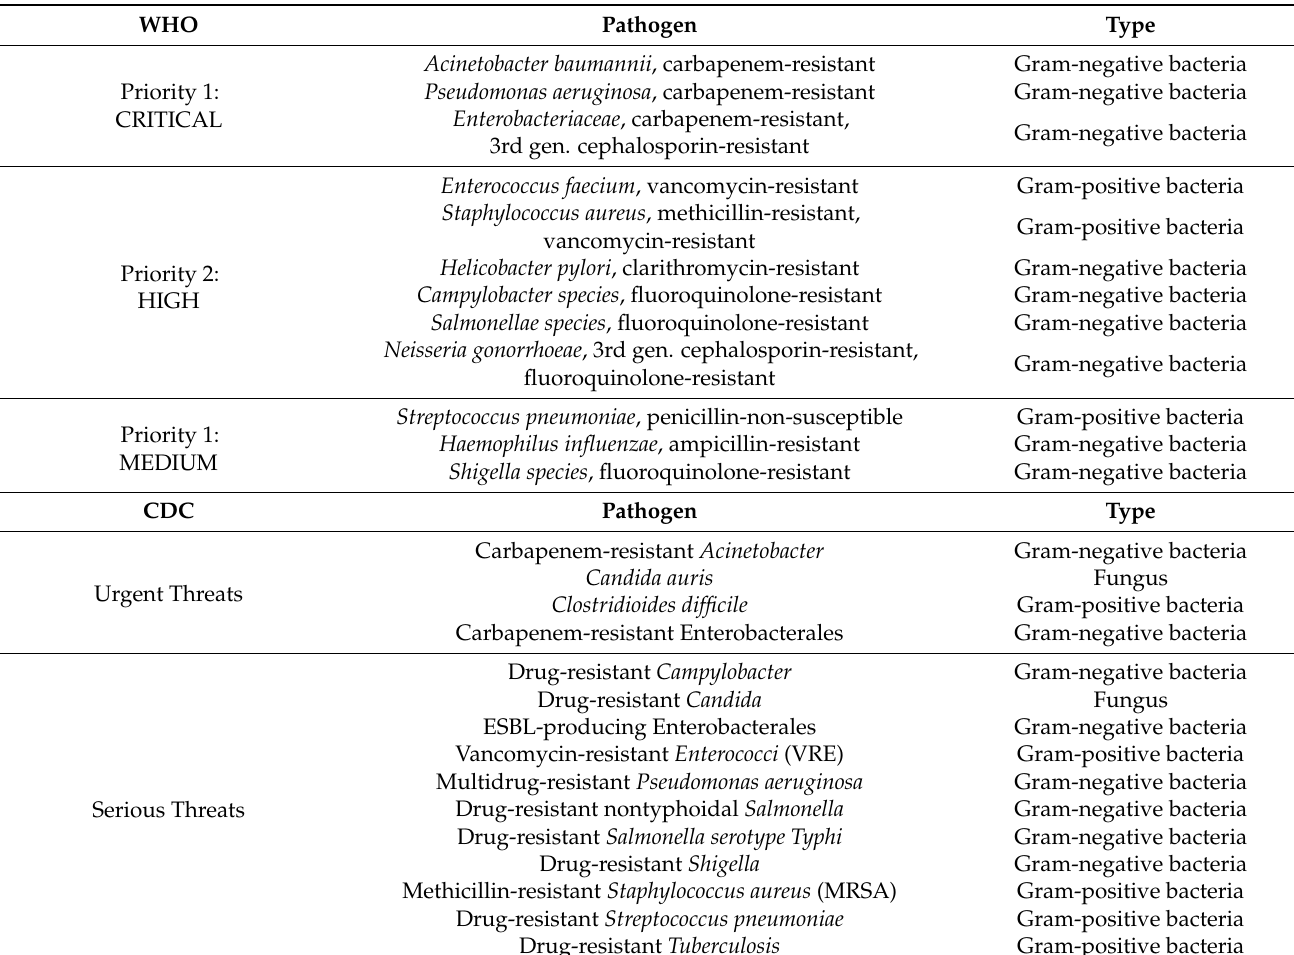
Table 1. World Health Organization (WHO) priority pathogens for R&D of new antibiotics (released in 2017) and Centers for Disease Control and Prevention (CDC) antibiotic resistance threats in the United States (released in